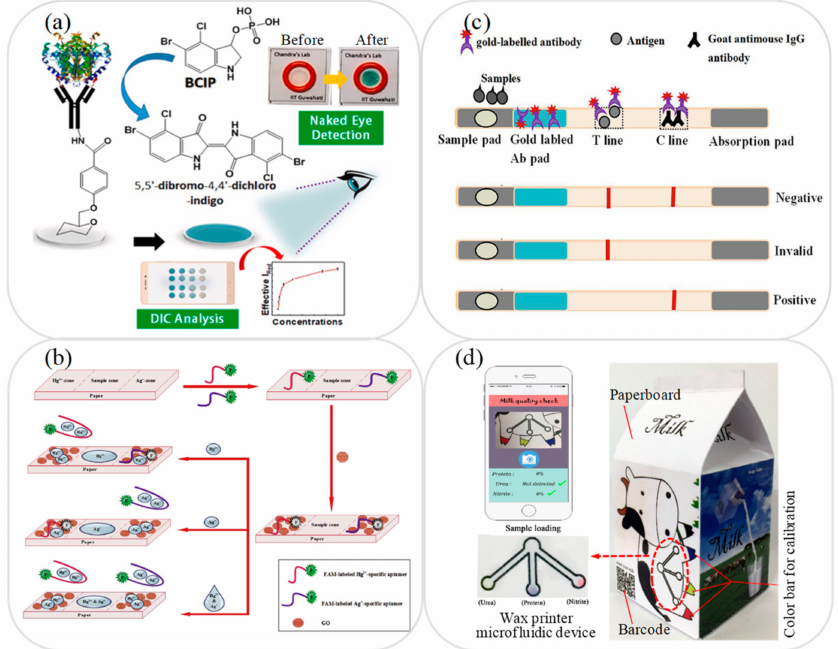
Figure 5. ( a ) Schematic illustration showing working principle of microfluidic immunosensor de- vice for dual naked eye/colorimetric detection of ALP concentration. Reprinted with permission from ref. [110]. Copyright 2019 Elsevier. ( b ) Schematic illustration showing working principle of microfluidic aptasensor device with FRET process for detection of Hg 2+ and Ag + ions. Reprinted with permission from ref. [112]. Copyright 2020 Elsevier. ( c ) Schematic illustration showing working principle of microfluidic immunoassay device for detection of lactoferrin. Reprinted with permission from ref. [113]. Copyright 2021 Elsevier. ( d ) Schematic illustration and photograph showing milk carton with integrated microfluidic colorimetric device for rapid milk quality testing. Reprinted with permission from ref. [116]. Copyright 2018